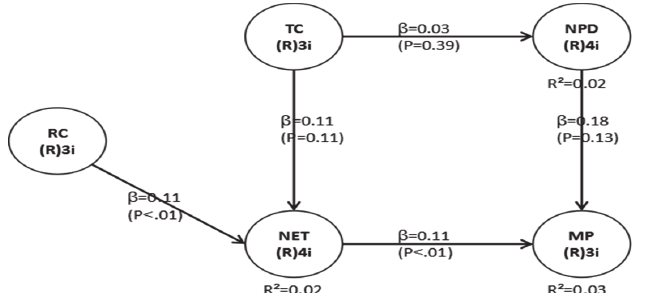
Fig. 1. Full structural model analysis